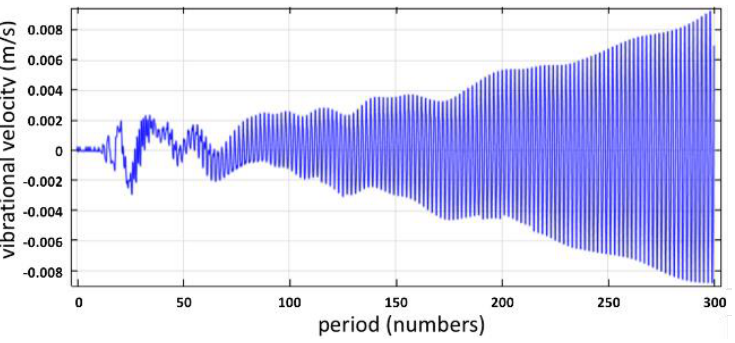
Figure 7. At the position (L/2, h), the vibrational velocity varies with the time period for h cr = 0.38 μ m.